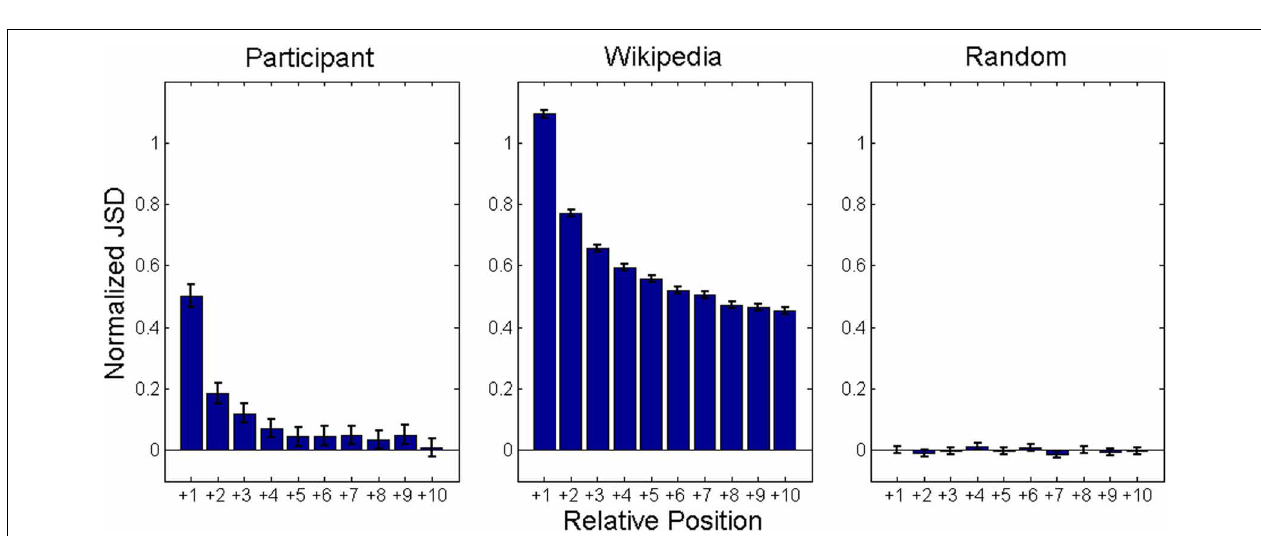
FIGURE 5 | Mean normalized JSD values between animal names produced 1–10 responses apart in category recall sequences. JSD values normalized by mean and standard deviation all possible JSD values between items produced. Analysis based on Figure 1 from Hills et al.